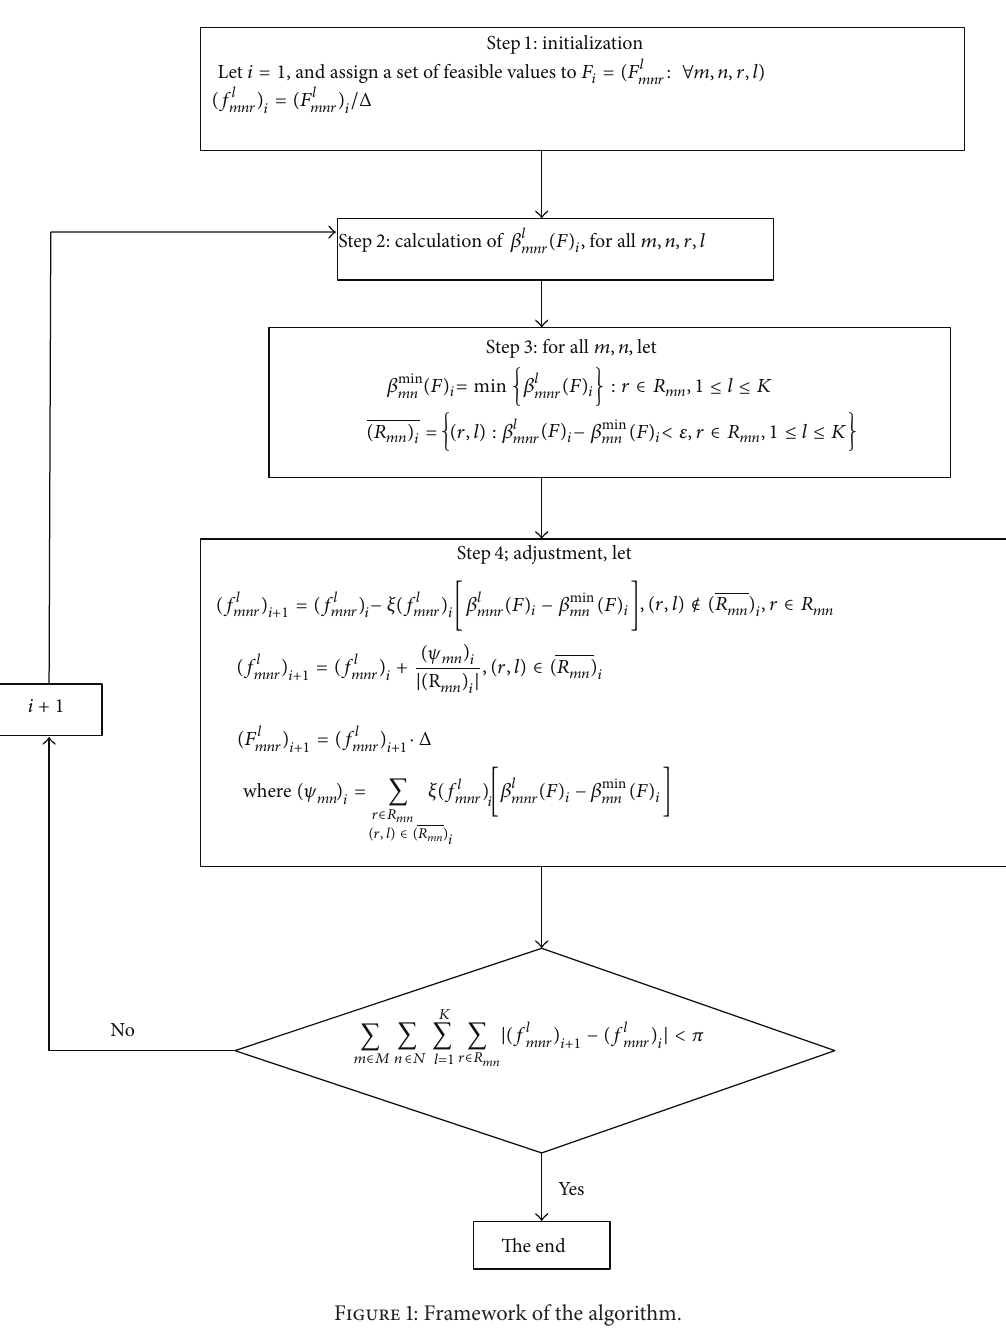
Figure 1: Framework of the